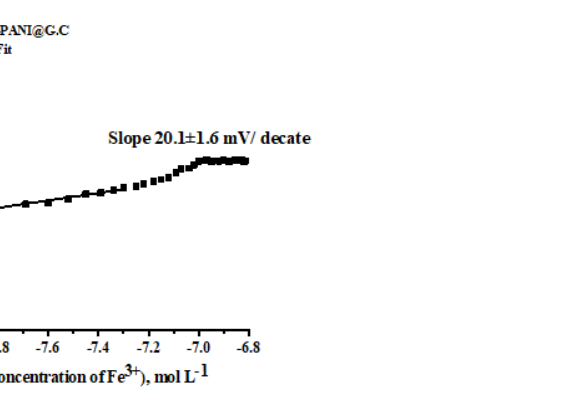
Figure 7. Potentiometric detection of Fe 3+ ions by POX/C-PANI@G.C in the presence of Cu 2+ ions.